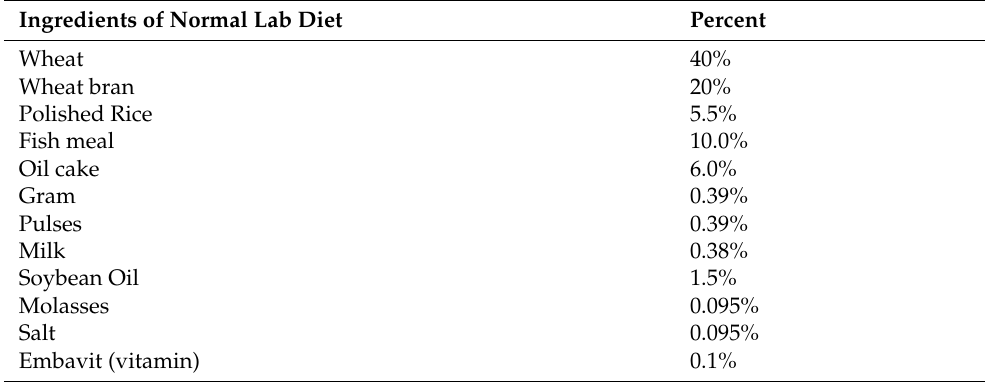
Table 1. Composition of normal food formulation used in this study (for 100